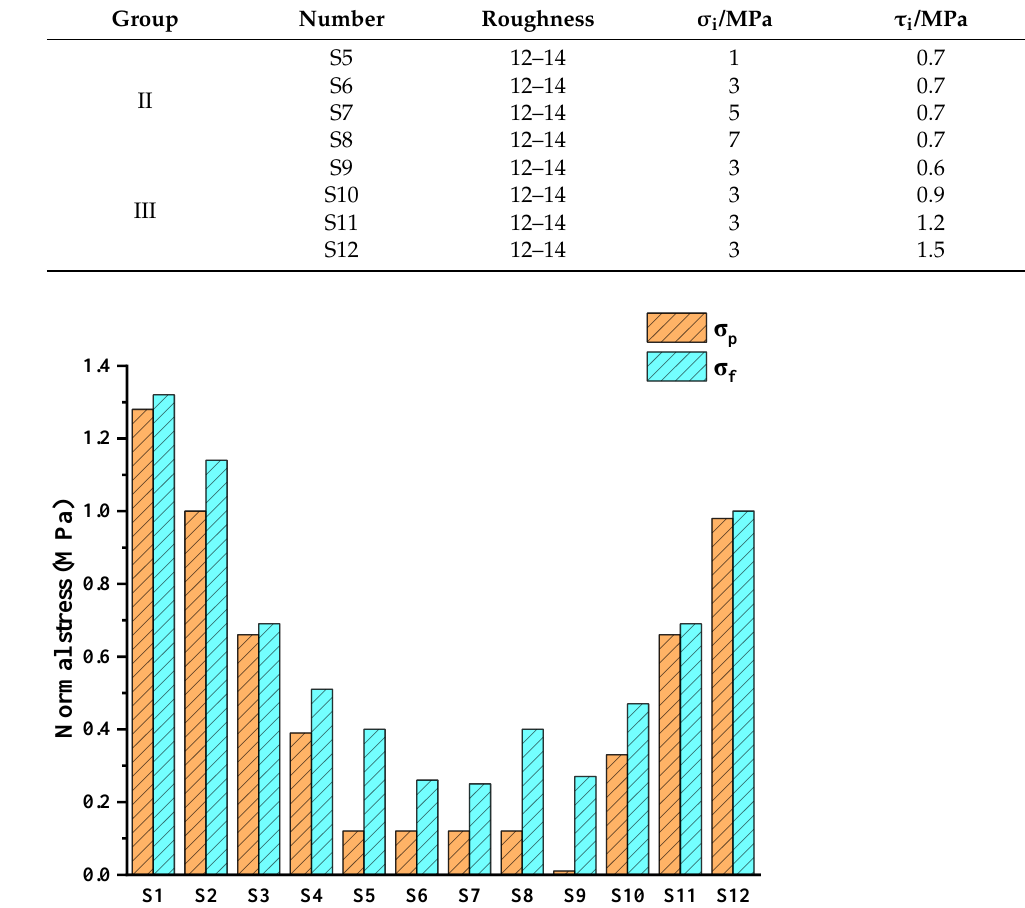
Table 3. Specimen parameters.